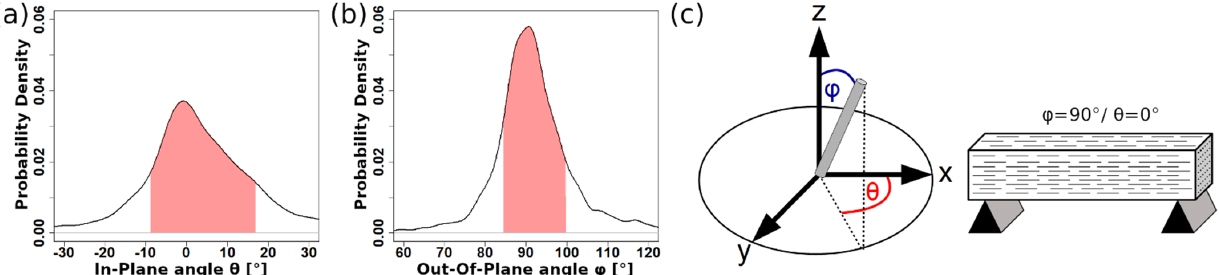
Figure 3. ( a ) Distribution of in-plane alignment angles ( θ -angles or yaw). ( b ) Distribution of out-of-plane alignment angles ( ϕ -angles or pitch). ( c ) Depiction of the coordinate system used for definition of angles. The desired alignment angle is pointing in the x-direction, i.e., θ = 0° and ϕ = 90°. The area shaded in red in ( a , b ) denotes a standard deviation of a single σ , i.e., 68% of values scattering around the mode of the distribution.